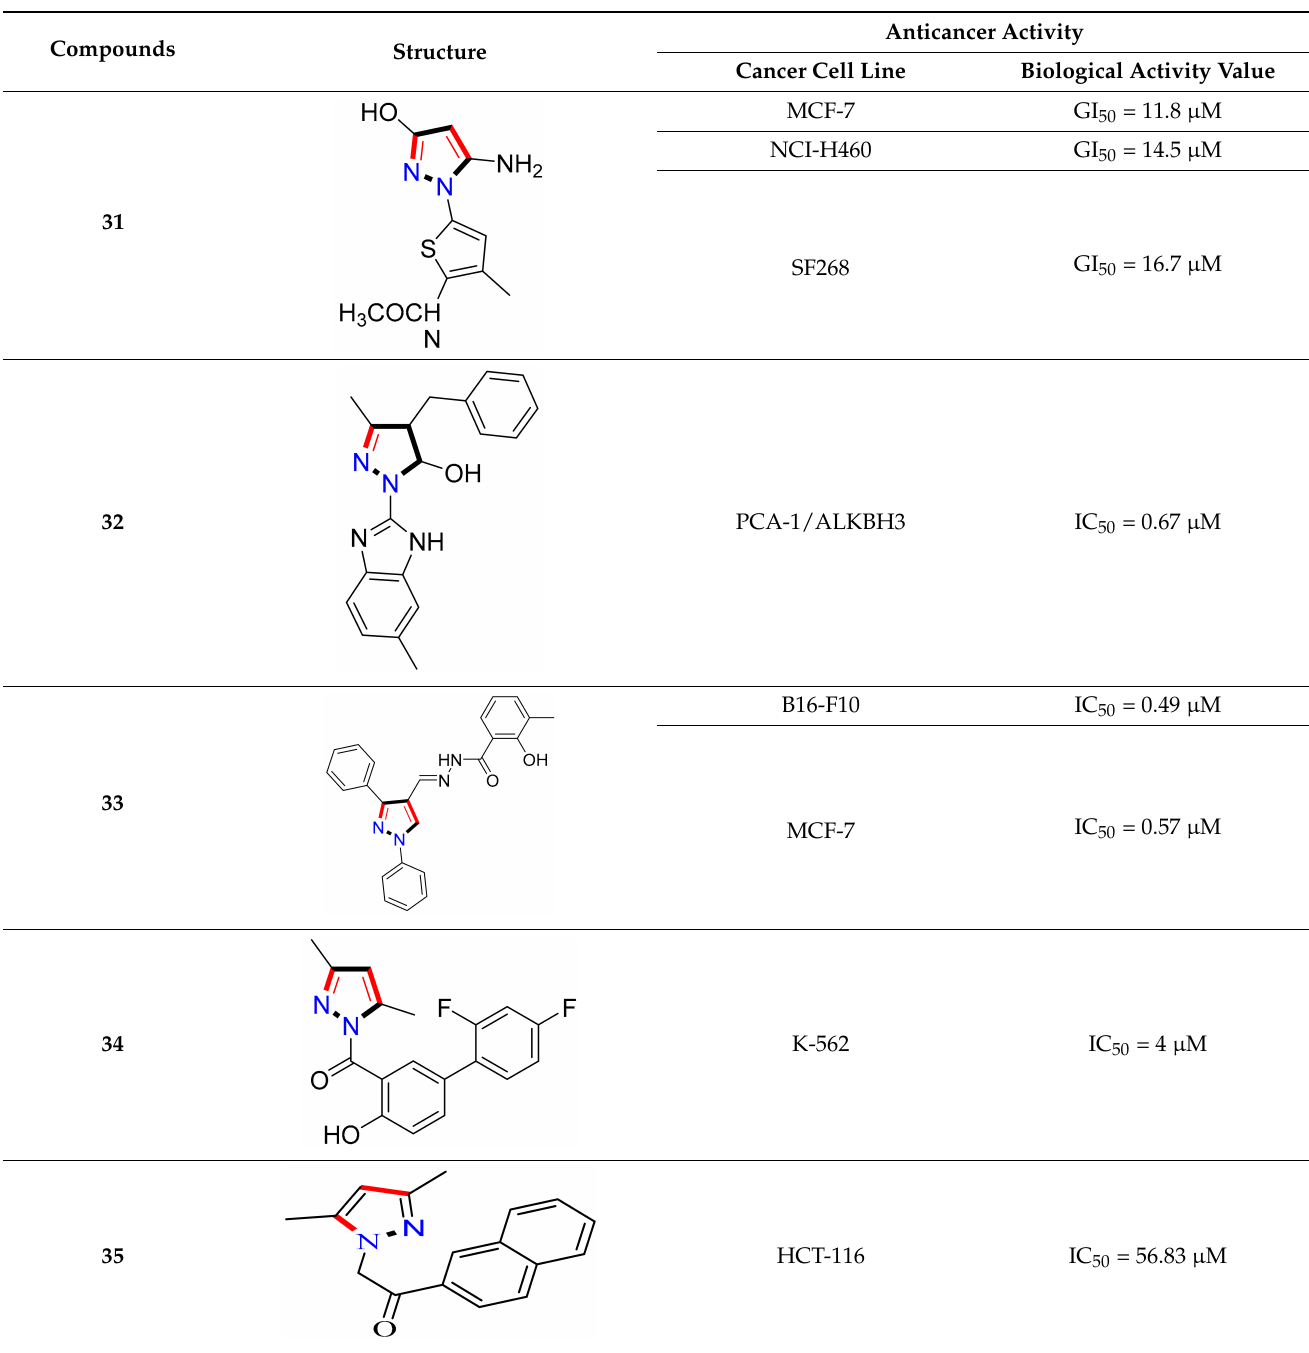
Table 4. Representative compound structures 31 to 47 and their anticancer